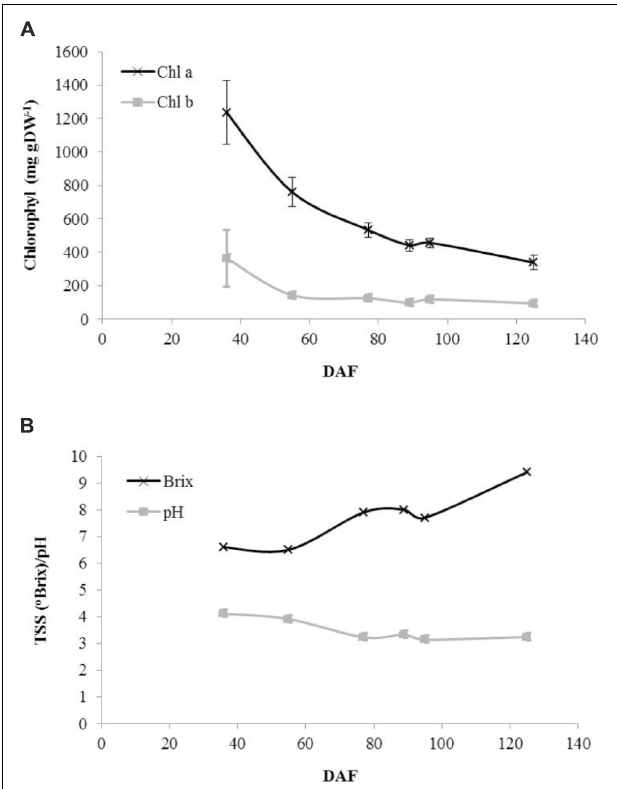
FIGURE 2 | Developmental profiles of fruit pigments and juice characteristics in blackcurrant. Chlorophyll was extracted and quantified from lyophilised fruit as described and is represented as mean ± SE, n = 3 (A) . Juice Brix and pH values were estimated as described from prepared juice samples (B) . DAF, days after